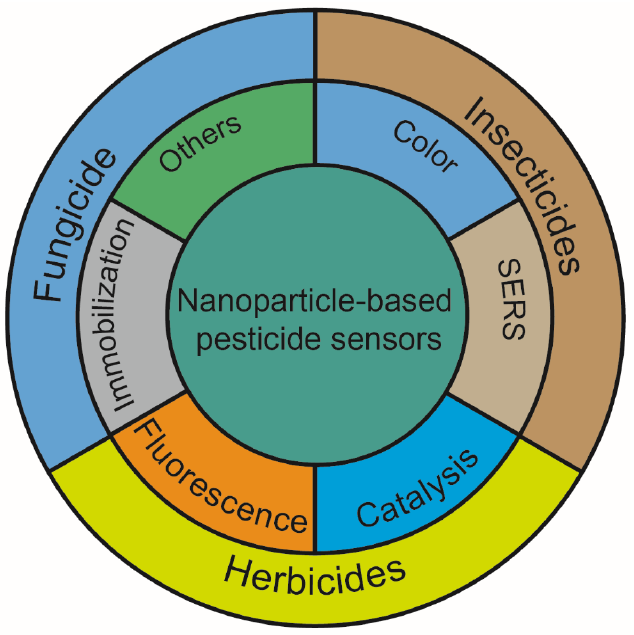
Figure 1. The functions of nanoparticles and their application in soil pesticide detection.